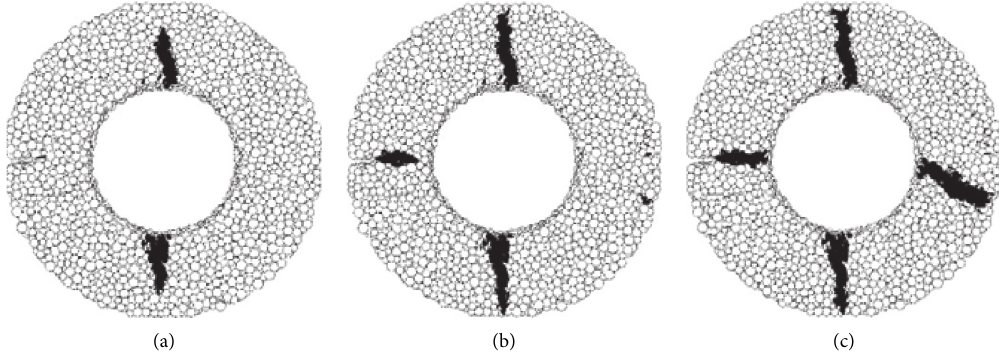
Figure 26: Microcracks distribution in ECFR specimen (C4). (a) Crack initiation. (b) Crack growth. (c) Sample failure.